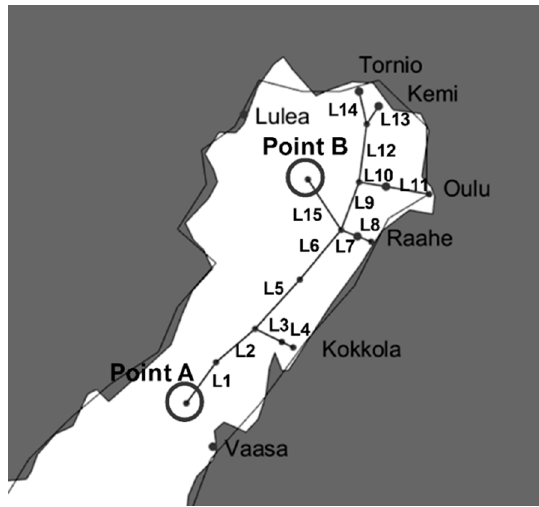
Figure 4. Navigation legs (L) and ports.